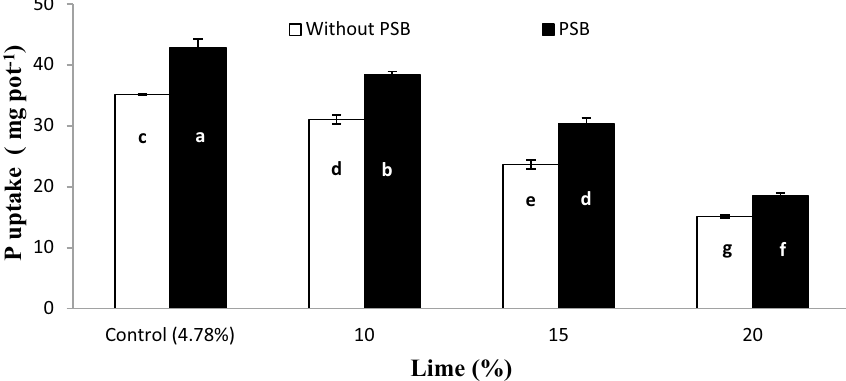
Figure 10. Plant P uptake (mg kg −1 ) affected by lime and PSB . Errors bar represent standard error for the mean of three values. Graph bars sharing letters are statistically comparable at p ≤ 0.01.